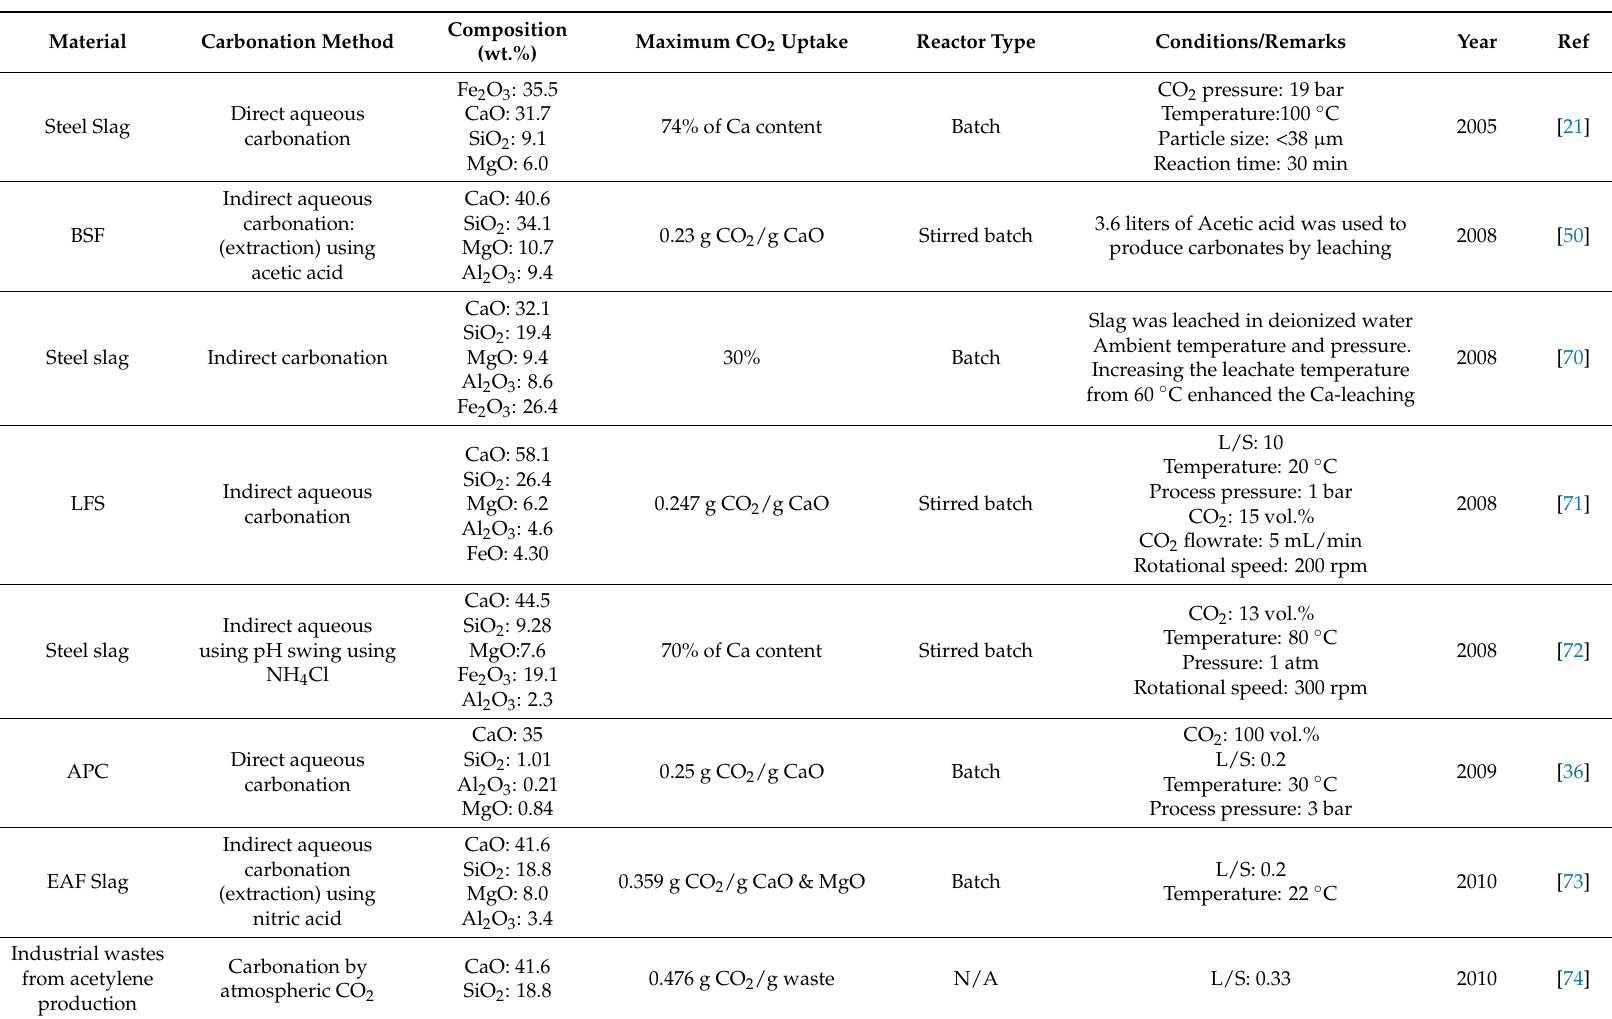
Table 8. Summary of the tested steel slag for mineral carbonation in terms of CO 2 capture capacity, feedstock composition and process parameters.